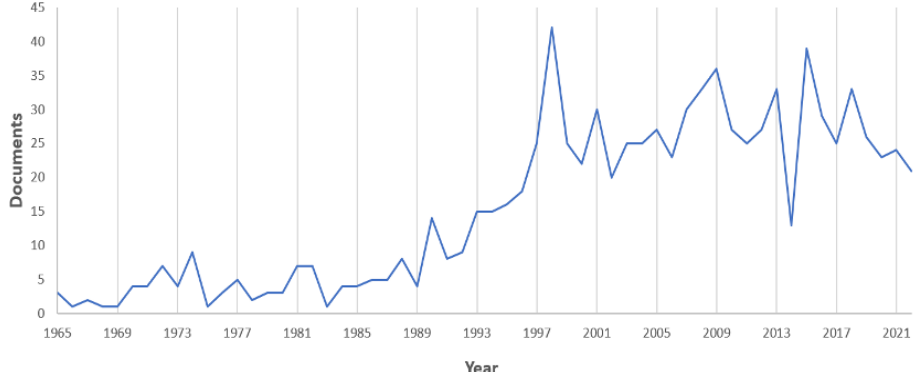
Figure 1. Temporal trend in published papers on N. norvegicus showing a sharp increase after 1989 onward. The last year (2022) is not finalized, so the total number of published papers is still incomplete (i.e., runs until the 15 August).